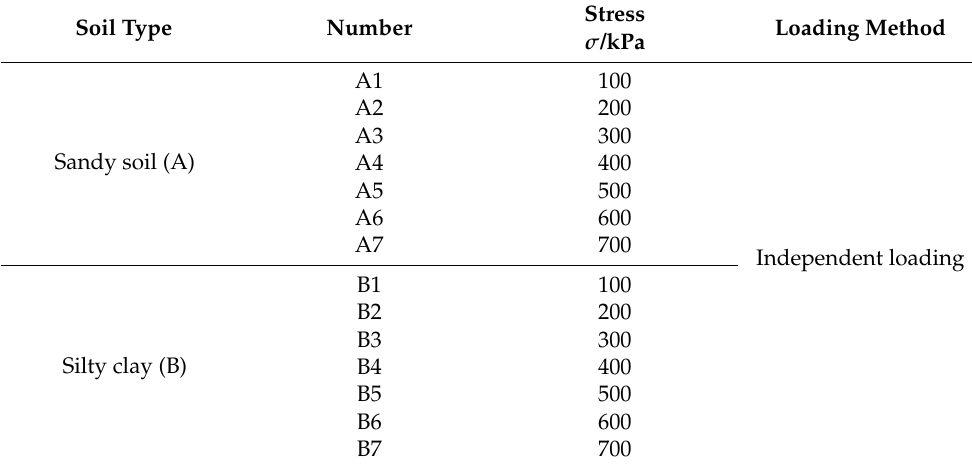
Table 2. Experimental scheme for creep test of soil